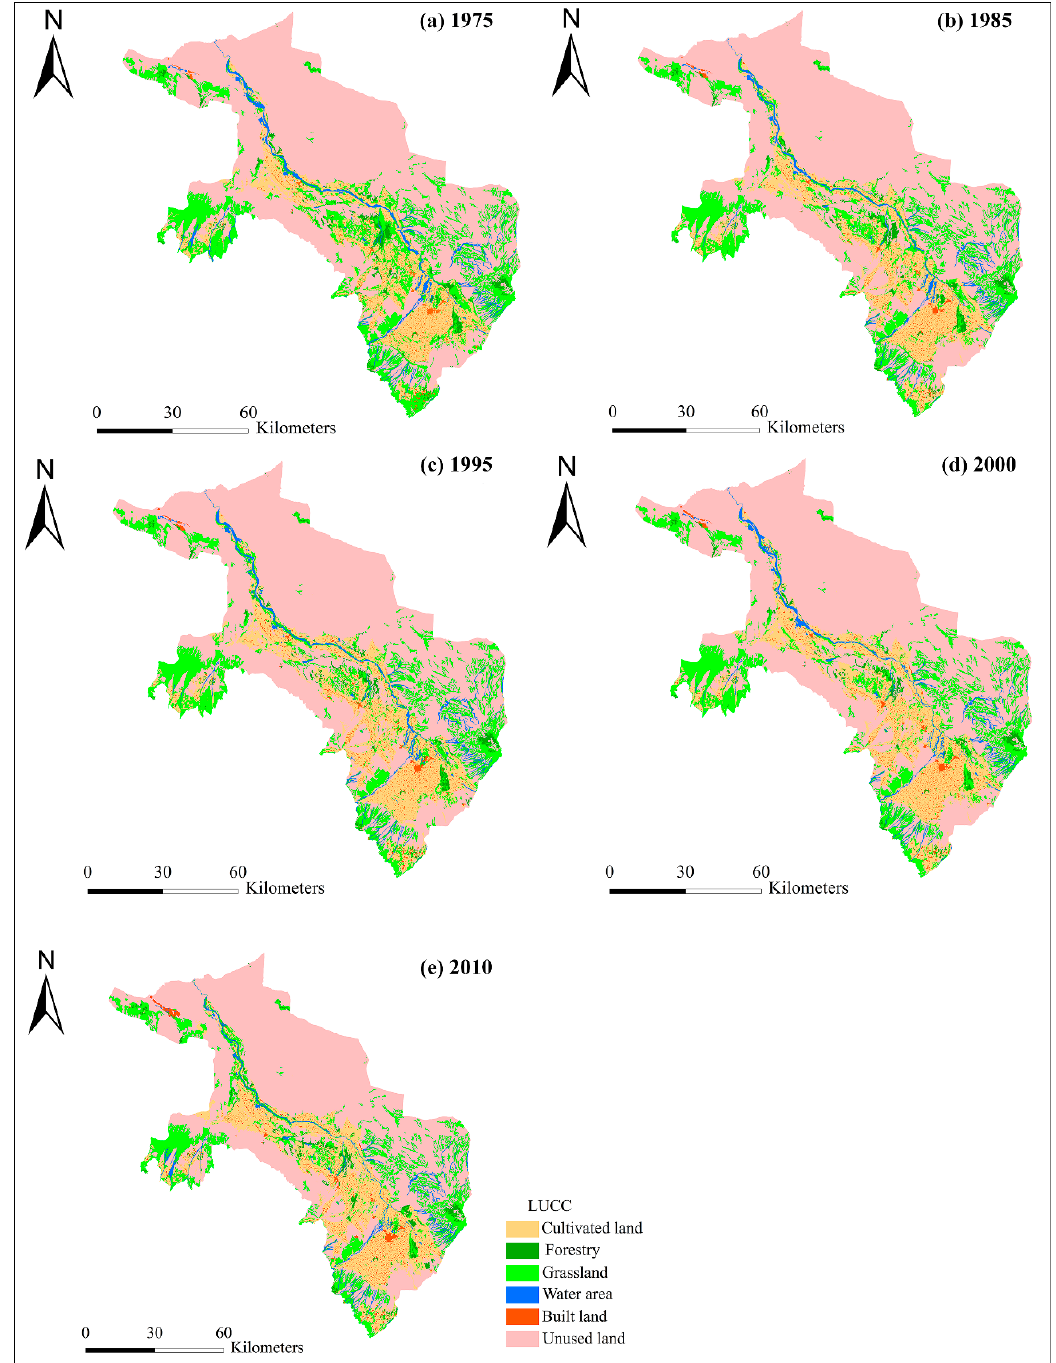
Figure 12. Spatial distribution of the changes in land use / cover pattern in the middle Heihe River Basin (MHRB)